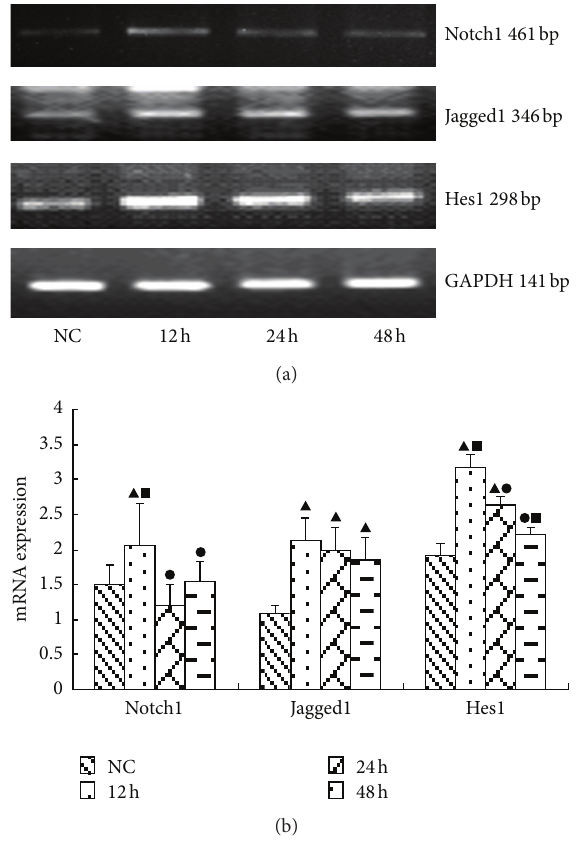
Figure 4: The mRNA levels of FN in each group of GMCs. (a) RT-PCR strip chart for different times. The mRNA expression of all Notch signaling components were significantly upregulated at the 12h time point. The expression of Notch1 mRNA was enhanced significantly at the 12h time point. The expression levels of Hes1 mRNA were upregulated significantly at the 12h and 24 h (𝑃 < 0.05) time points, with the 12h increase being more obvious. (b) The corresponding relative gray value statistics graph of the mRNA level. 󳵳 𝑃 < 0.05 versus NC group; ∙ 𝑃 < 0.05 versus 12h group; ◼ 𝑃 < 0.05 versus 24 h